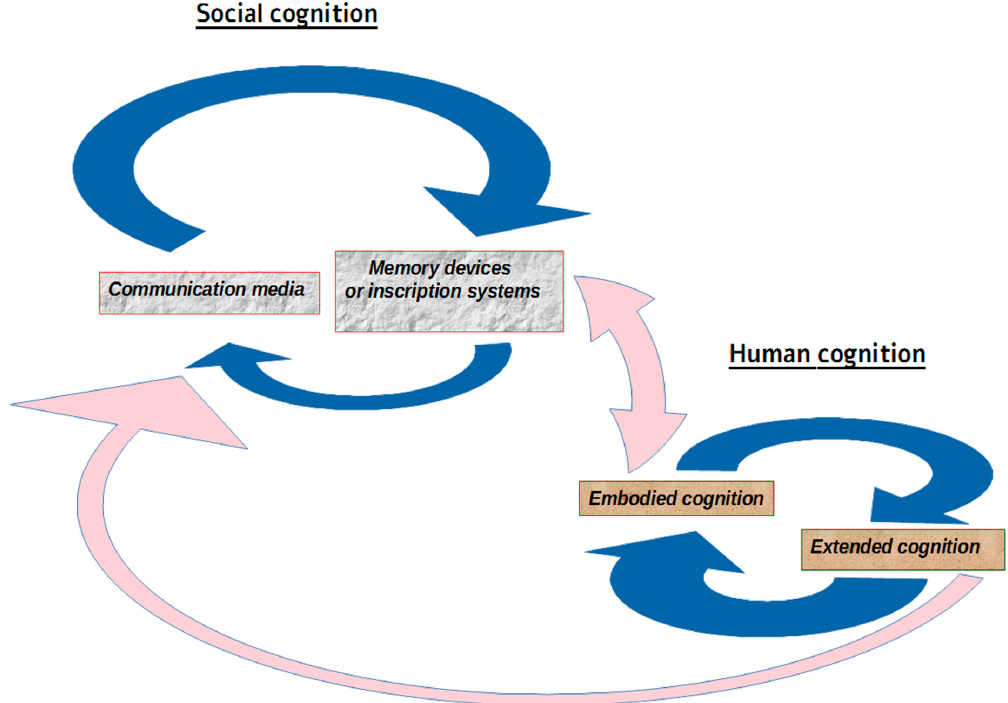
Figure 1. The double closure of human cognition and social cognition as a more accurate description of the structural coupling between social systems and their human environment. In the first loop social cognition feedback upon itself by differentiating between communication media and memory functions—the latter accomplished by material devises and/or material surfaces. In the second loop human cognition entangles embodiment and extension into a positive feedback loop. Both act as couplings to the social environment—although humans can only interact with materialities. Within this framework information appears in every complex system as entropy, uncertainty, and the balancing of redundancy and variety, for information-processing is a fundamental trait of cognition in general, whether biological (human), physical, artificial or social. Meaning appears instead within the context of the expectations structures emerging from human behavior and language as both: A form of embodied cognition and a communication medium. Herein, expectations structures guide the self-organizing patterns of the social system, as a result, the domain of what is socially possible acquires the character of information; as long as language becomes a touchstone of human behavior and cognition, meaning emerges as the integration or operational coupling between the socio-biological behavior and the communicative emergent level of expectations structures. The